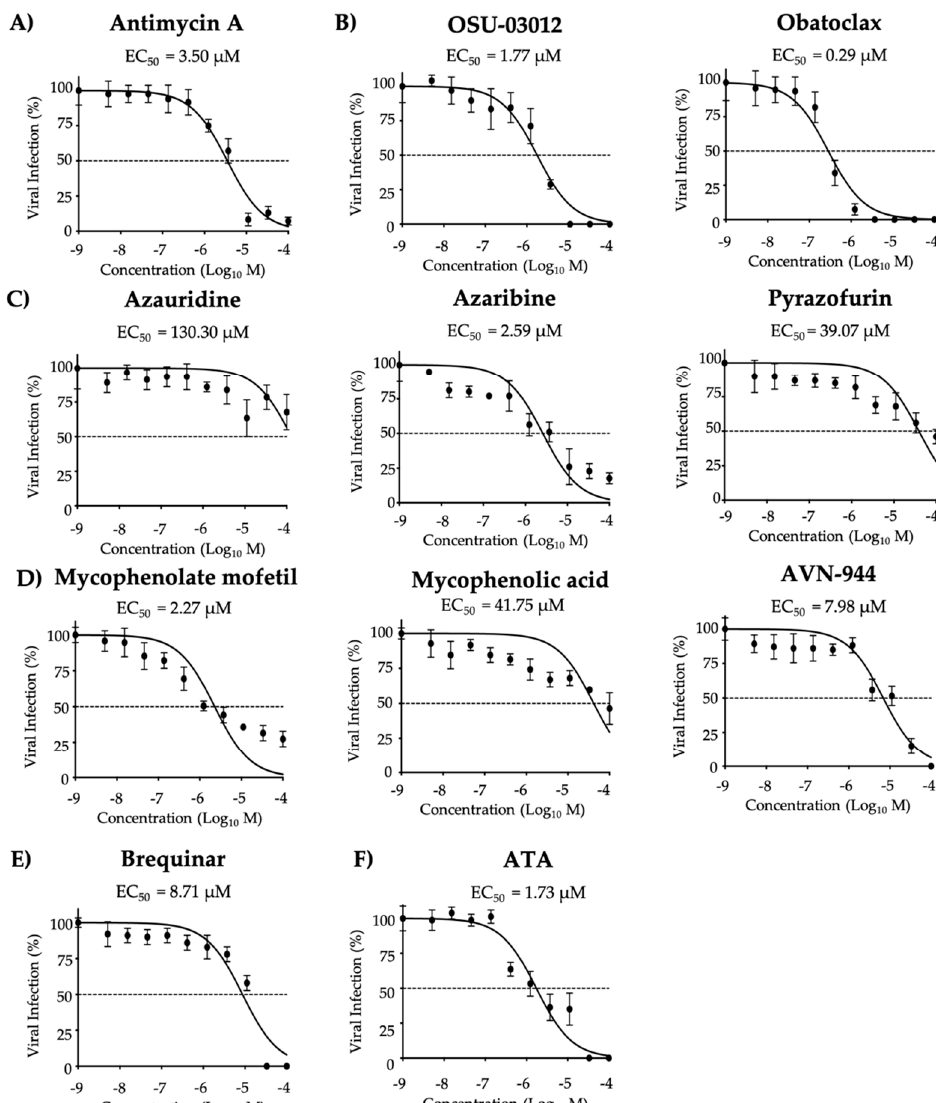
Figure 6. Inhibition of ZIKV Paraiba / 2015 with the compounds (co-treatment): ZIKV Paraiba / 2015 (25 PFU / well) were pre-incubated in infection media (DMEM 2% FBS) containing the indicated concentrations of the compounds (3-folds dilutions, starting concentration 100 µ M) ( A ) Antimycin A, ( B ) OSU-03012 and Obatoclax, ( C ) Azaribine, Azauridine, and Pyrazofurin, ( D ) Mycophenolate mofetil, Mycophenolic acid, and AVN-944, ( E ) Brequinar, and ( F ) Aurintricarboxylic acid (ATA) for 1 h. Vero cells (96-well plates, 5 × 10 4 cells / well; quadruplicates) were then infected with the virus-compound mixtures and after 2 h viral absorption, media was replaced by post-infection media. At 36 h post-infection, the cells were fixed and immunoassayed with the anti-E 4G2 mAb. Plaques were counted with an automated ELISPOT reader. Dotted line indicates 50% inhibition. Data were expressed as mean and SD from three independent experiments conducted in quadruplicates.